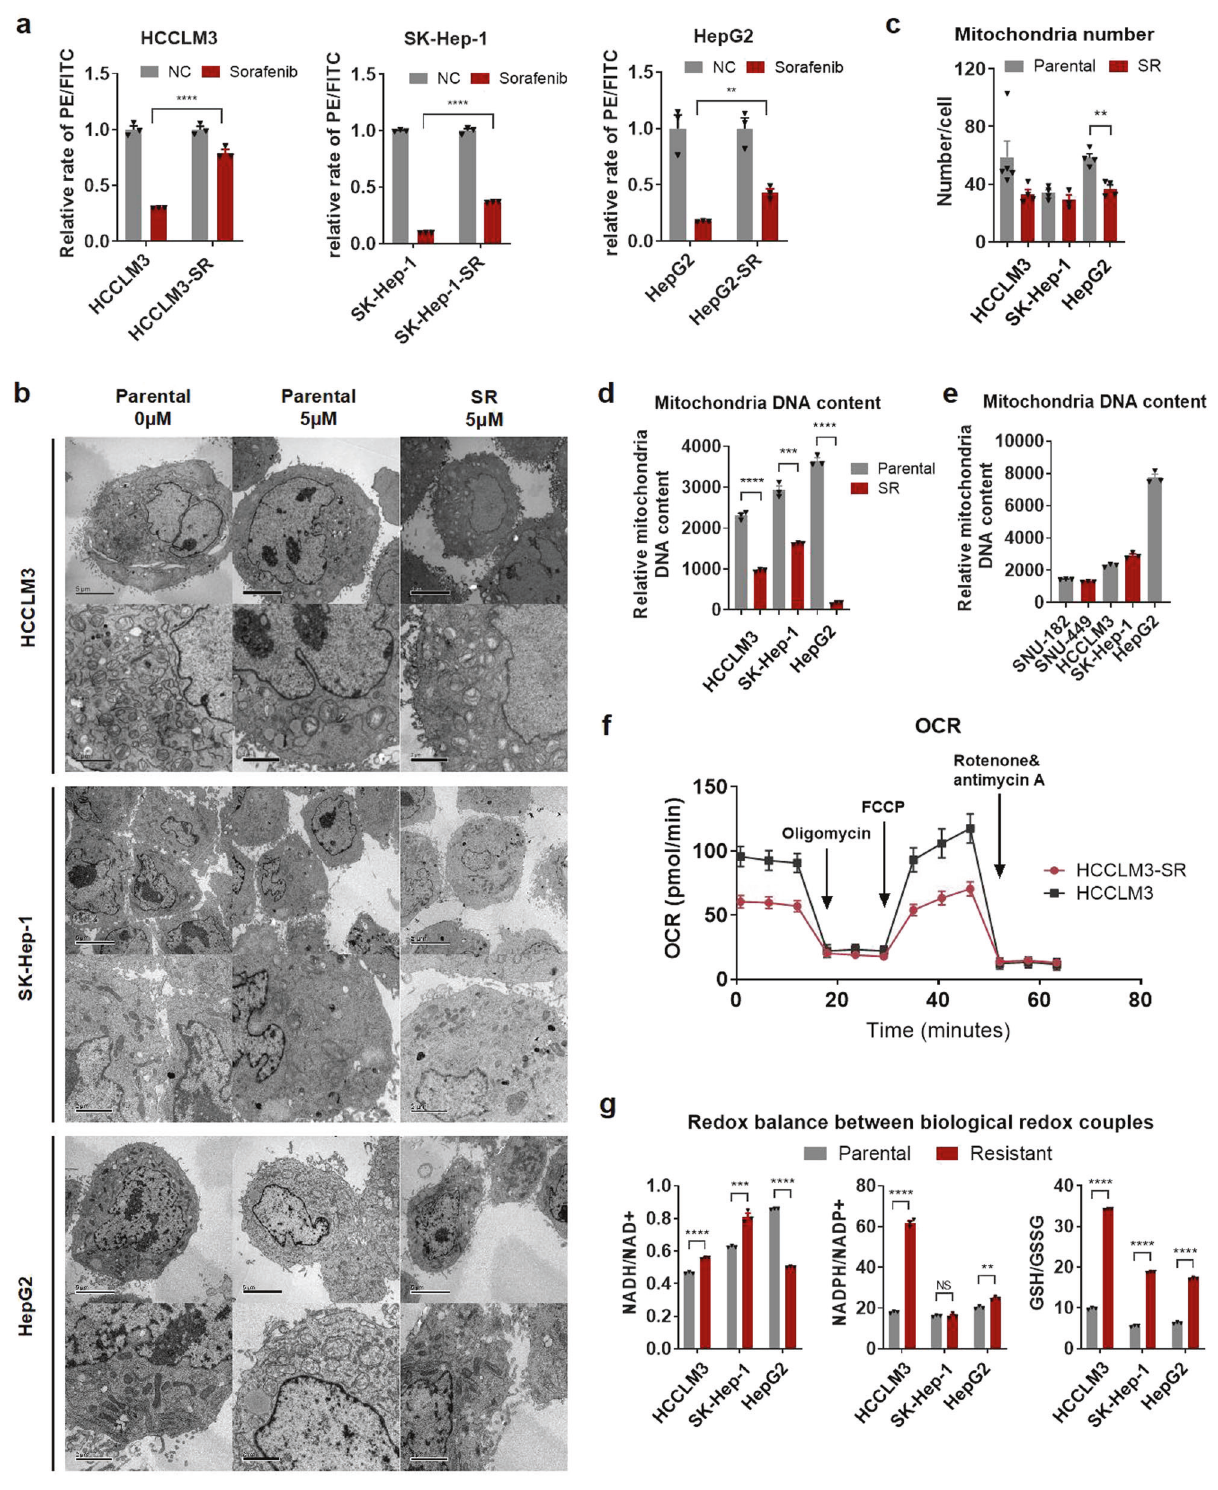
Fig. 2 Sorafenib-resistant cells retains better mitochondrial function and integrity with less mitochondrial content and respiratory capacity. a Mitochondrial membrane potential (MMP) was measured using a Mitochondria Staining Kit (JC-1). Flow cytometry revealed decreased mitochondrial membrane potentials (MMP) after 48 h of sorafenib treatment (5 µM) in parental cells, and much less in resistant cells. b Representative transmission electron microscopy (TEM) images of mitochondrial morphological changes during sorafenib treatment. Mitochondria in resistant cells maintained an intact morphology during sorafenib treatment, whereas those in parental cells were altered. Scale bar, 5 µm. c The numbers of mitochondria were determined via TEM. d , e Mitochondrial DNA content was measured by qRT-PCR. f Oxygen consumption rate (OCR) analysis using Seahorse analysis revealed compromised mitochondrial function in HCCLM3 cells. g Redox balances between biological redox couples of GSH/GSSG, NADPH/NADP, and NAD/NADH in parental and sorafenib-resistant cells were monitored. ** p < 0.01, *** p < 0.001, and **** p < 0.0001. NS not statistically signi fi cant Signal Transduction and Targeted Therapy (2021)